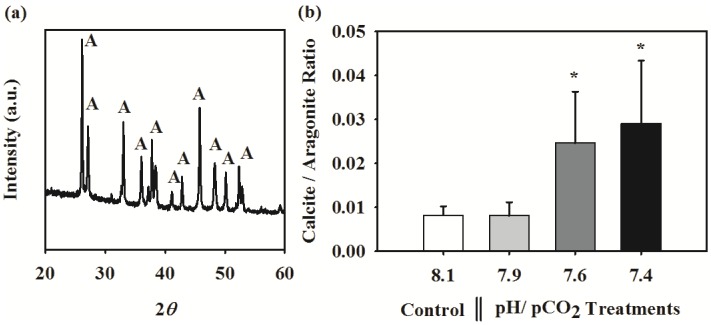
Effects of pH/pCO2 on shell mineralogy in the juvenile tubeworm, Hydroides elegans.(a) The X-ray diffraction pattern of shell obtained from the control pH/pCO2 (pH 8.1) showing the presence a set of diffraction peaks resulting from the presence of the dominating aragonite (A) phase. (b) Effect of pH/pCO2 on the shell calcite/aragonite ratio, which was quantified from the X-ray diffraction analysis. Each bar represents the mean ± SD of 5 biologically independent measurements each obtained from independent culture. The asterisk (*) shown on the bar indicates a significant difference between the control and the treatment according to the Dunnett's Post-hoc test (p<0.05).